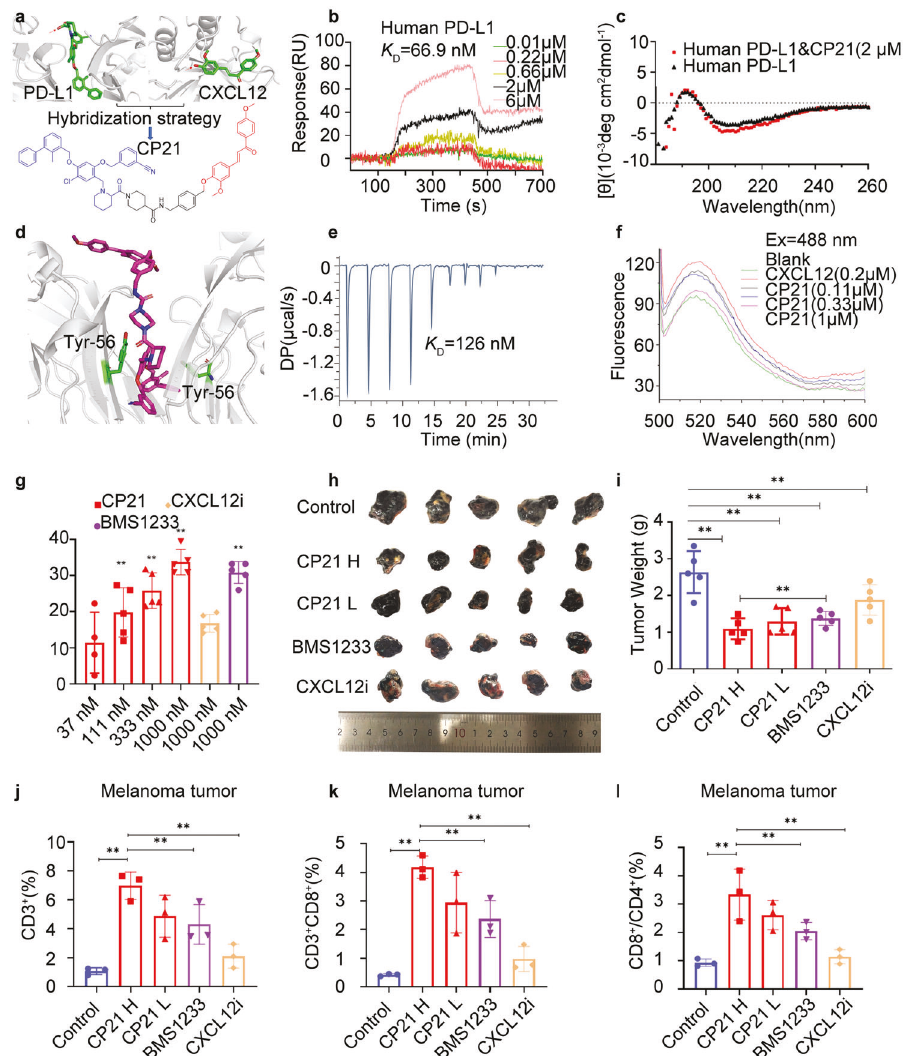
Fig. 1 a Design of bifunctional molecules targeting PD-L1/CXCL12 based on the pharmacophores of CXCL12 inhibitors and PD-L1 inhibitors. b The binding af fi nity of CP21 to hPD-L1 as measured by SPR. c CD spectra of hPD-L1 in complex with or without CP21 . d Docking of CP21 to hPD-L1 (PDB code: 6R3K). e ITC study for CP21 in complex with hPD-L1. f Intracellular Ca 2 + release was measured by spectro fl uorometry in THP-1 cells. g Effects of CP21 and BMS-1233 (positive control) on HepG2 cell mortality in Jurkat T cell&HepG2 co-culture system ( n = 5, ** P < 0.05). h Therapeutic effects of CP21 ( h , 125 mg/kg; l , 75 mg/kg), BMS-1233, and CXCL12i (inhibitor) against B16-F10 melanoma tumors in mice ( n = 5). i Average tumor weights (** P < 0.05, n = 5). Percentages of CD3 + cells ( j ) and CD3 + CD8 + cells ( k ), and the ratio of CD8 + /CD4 + cells ( l ) in tumor tissues ( n = 3, ** P <